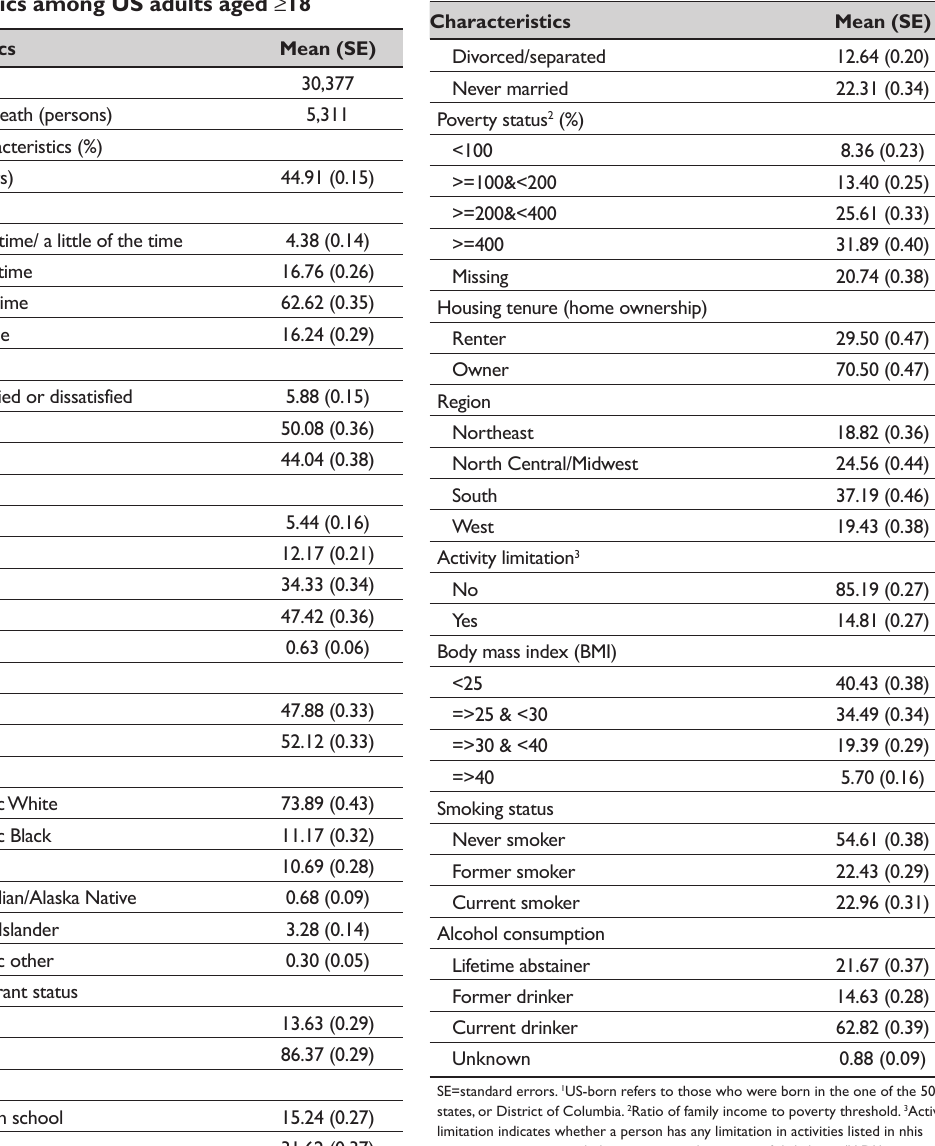
Table 1: ( Continued )Table 1: Descriptive statistics of